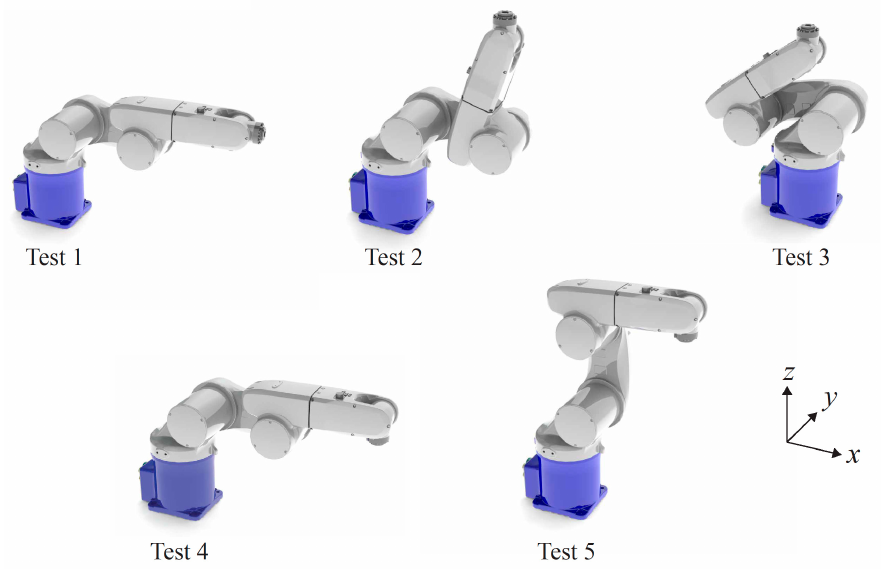
7 of 19 Figure 3. Mean values and standard deviations of mass matrix terms ( 10 (cid:2874) random configurations), direct inertia terms (red bars) and inertial cross-coupling terms (blue bars). In a specific configuration, the inertial cross-coupling terms of joint 𝑖 ( 𝑀 (cid:3036)(cid:3037) ,𝑗 ≠ 𝑖 ) are small or